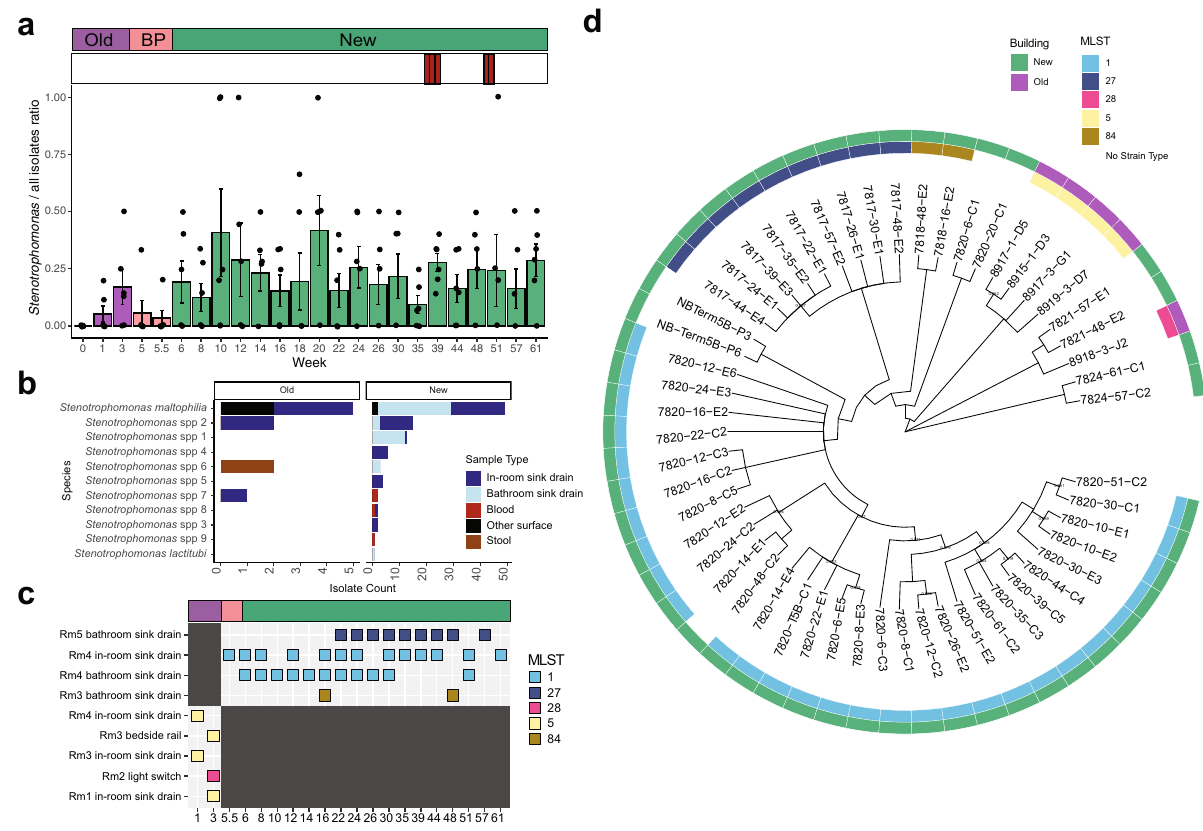
Fig. 3 Timing, identity, and phylogenetics of Stenotrophomonas isolates. a Ratio of Stenotrophomonas isolates to all isolates across all time points ( n = 128 Stenotrophomonas isolates). Error bars indicate standard error of intensive care unit (ICU) rooms. Red bars indicate collection timing of Stenotrophomonas blood culture isolates. b Identity of all collected Stenotrophomonas genomes by >95% average nucleotide identity (ANI) to reference genome by sample collection type ( n = 128 isolates). Other Surface indicates all other surface/water genomes apart from in-room and bathroom sink drain. All genomes were identi fi ed as Stenotrophomonas by MASH. Stenotrophomonas various genomospecies includes all different genomospecies that did not share >95% ANI with a reference genome. c Time point mapping of shared S. maltophilia MLST groups by sample collection location. d Cladogram built from a core genome alignment of S. maltophilia genomes. Branches with less than 80% bootstrap support are collapsed. Branches with bootstrap values between 80 – 95% are labeled. BP before patient and staff